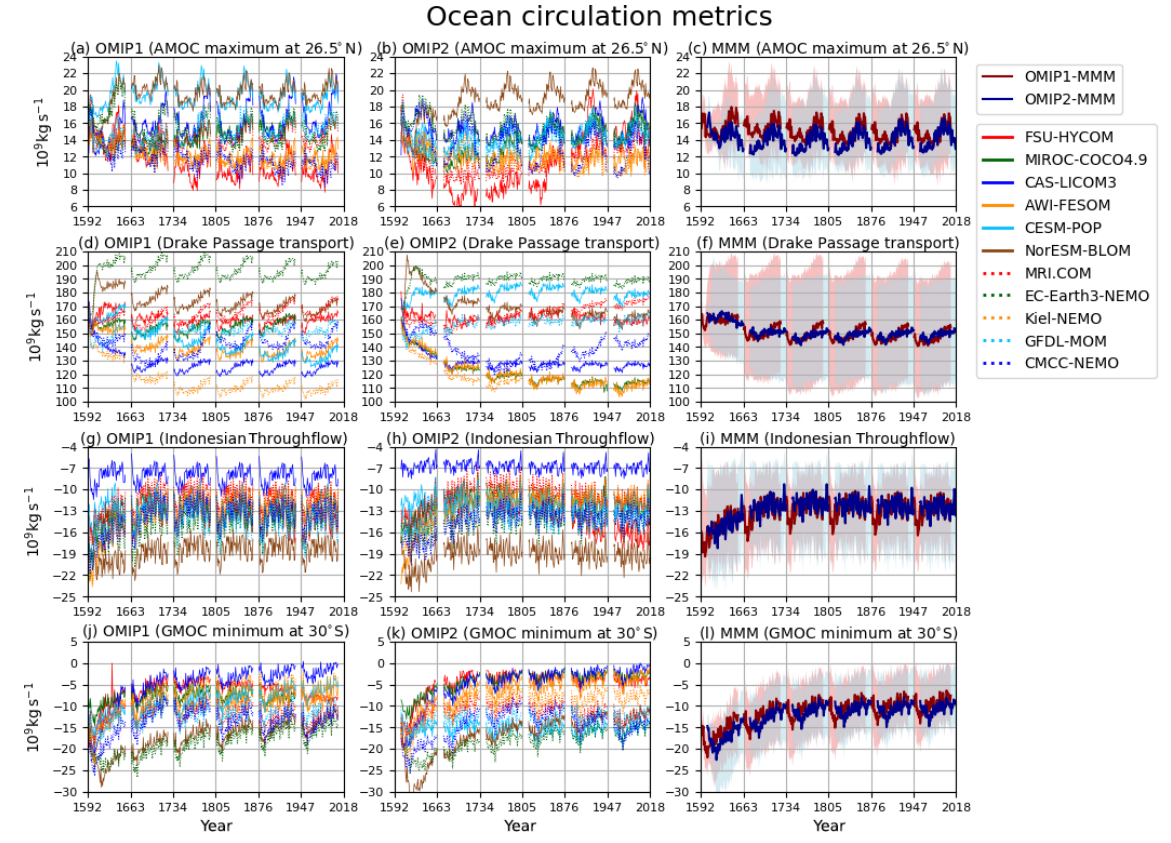
Figure 5. Time series of annual mean ocean circulation metrics. (a–c) AMOC maximum at 26.5 ◦ N, which approximately represents the strength of AMOC associated with the North Atlantic Deep Water formation. (d–f) Drake Passage transport (positive eastward), which represents the strength of Antarctic Circumpolar Current. (g–i) Indonesian Throughflow (negative into the Indian Ocean), which represents water exchange between the Pacific and Indian oceans. (j–l) Global meridional overturning circulation (GMOC) minimum in 2000m– bottom depths at 30 ◦ S, which represents the strength of deep to bottom layer GMOC associated with the Antarctic Bottom Water and Lower Circumpolar Deep Water formation. (a, d, g, j) OMIP-1 and (b, e, h, k) OMIP-2. (c, f, i, l) Multi-model mean (lines) and spread defined as the range between maximum and minimum (shades) of OMIP-1 (red) and OMIP-2 (blue). Units are 10 9 kgs − 1 . See Figs. S8 and S9 for a closer look at individual